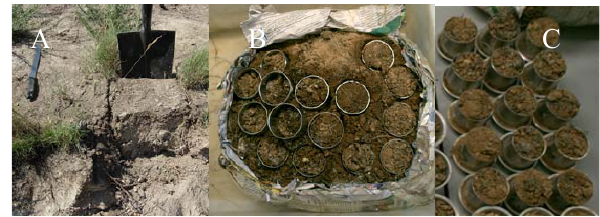
Fig. 1. Sample preparation: (A) block extraction, (B) subsamples of the blocks; and (C) sub-sample preparation.